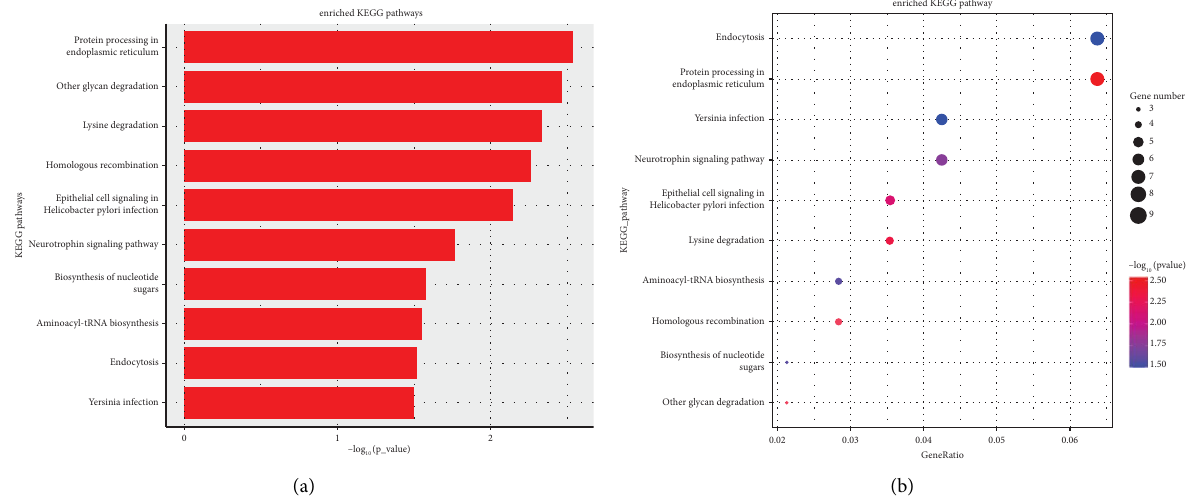
Figure 3: KEGG enrichment for the host genes of the upregulated circRNAs. (a) Te top 10 signifcantly enriched KEGG pathways of upregulated circRNAs are shown by the bar plot. Te horizontal axis represents the enrichment scores ( − log 10 [ P value]). (b) Bulb map displays the enriched KEGG pathways of the host genes of upregulated circRNAs. Te horizontal axis represents the enrichment degree of the upregulated genes. Te vertical axis displays the diferent terms of the top 10 pathways enriched by upregulated genes. Te number of enriched host genes of DE circRNAs is expressed by diferent node sizes. A color scale shows the diferent P